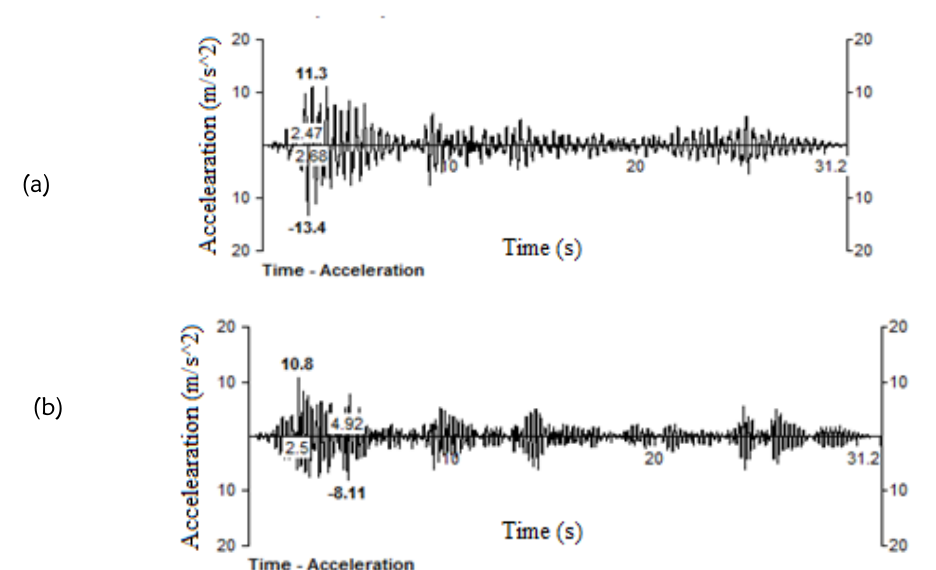
Figure 12: Time dependent peak-to-peak accelerations along x-direction for double story structure (a) unreinforced (24 . 7 ms -2 ) and (b) reinforced (18 . 91 ms -2 )